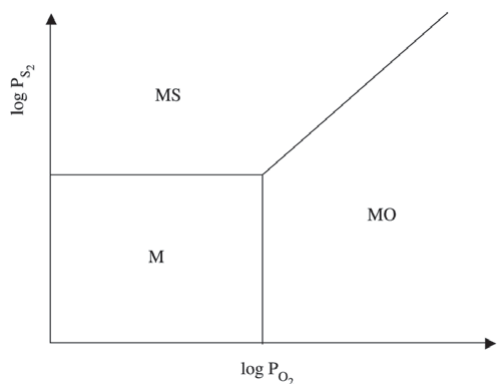
Figure 2. Schematic representation of a simple phase-stability dia- gram for a metal and its oxide and sulfide.